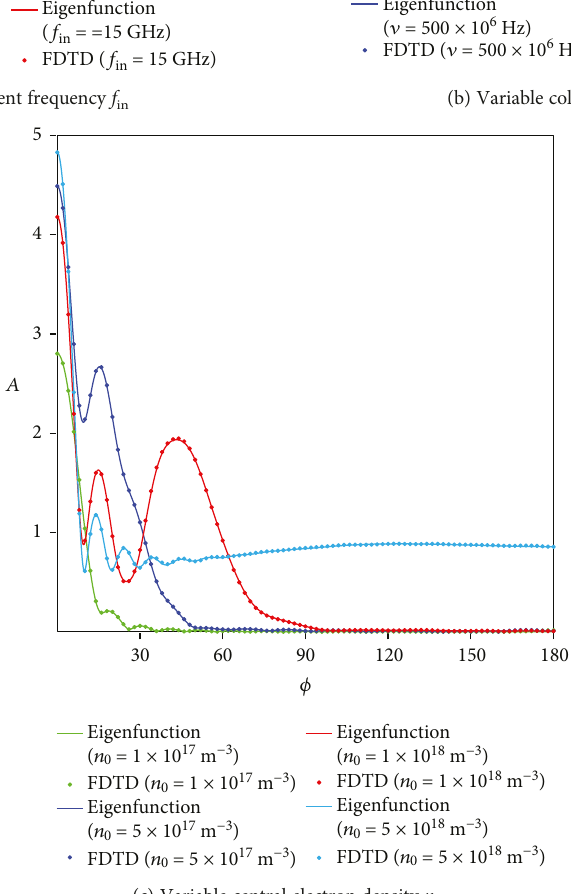
Figure 20: Comparison between the scattering amplitudes obtained by the eigenfunction method and the FDTD simulation for di ff erent variable parameters of the inhomogeneous